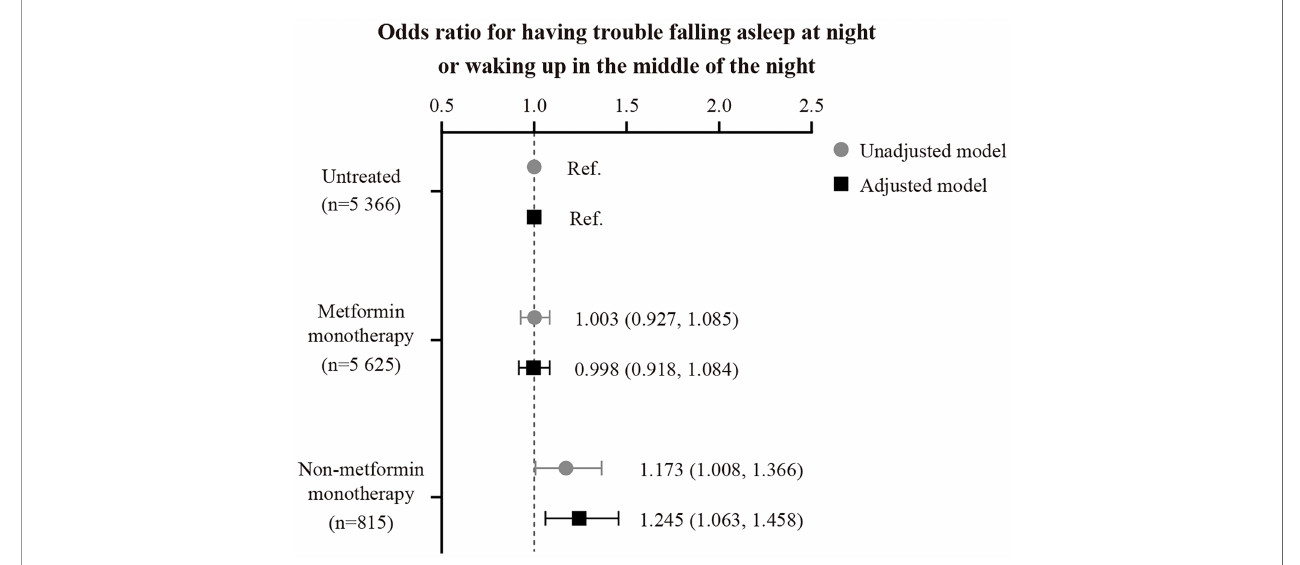
FIGURE 1 | Unadjusted and adjusted odds ratios and 95% CIs for having trouble falling asleep at night or waking up in the middle of the night, strati fi ed by the oral antidiabetic regimen. The adjusted model was controlled for patients ’ age, sex, BMI, UK Biobank assessment center, Townsend index, systolic blood pressure, snoring status, type 2 diabetes duration, HbA 1c , presence of cardiovascular disease, antidepressant therapy status, and statin therapy status.